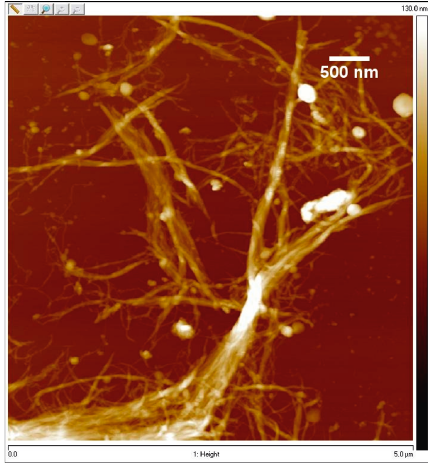
Figure 2: FTIR spectra of agave bagasse fibers, cellulose obtained by the organosolv method, and nanofibrillar cellulose.